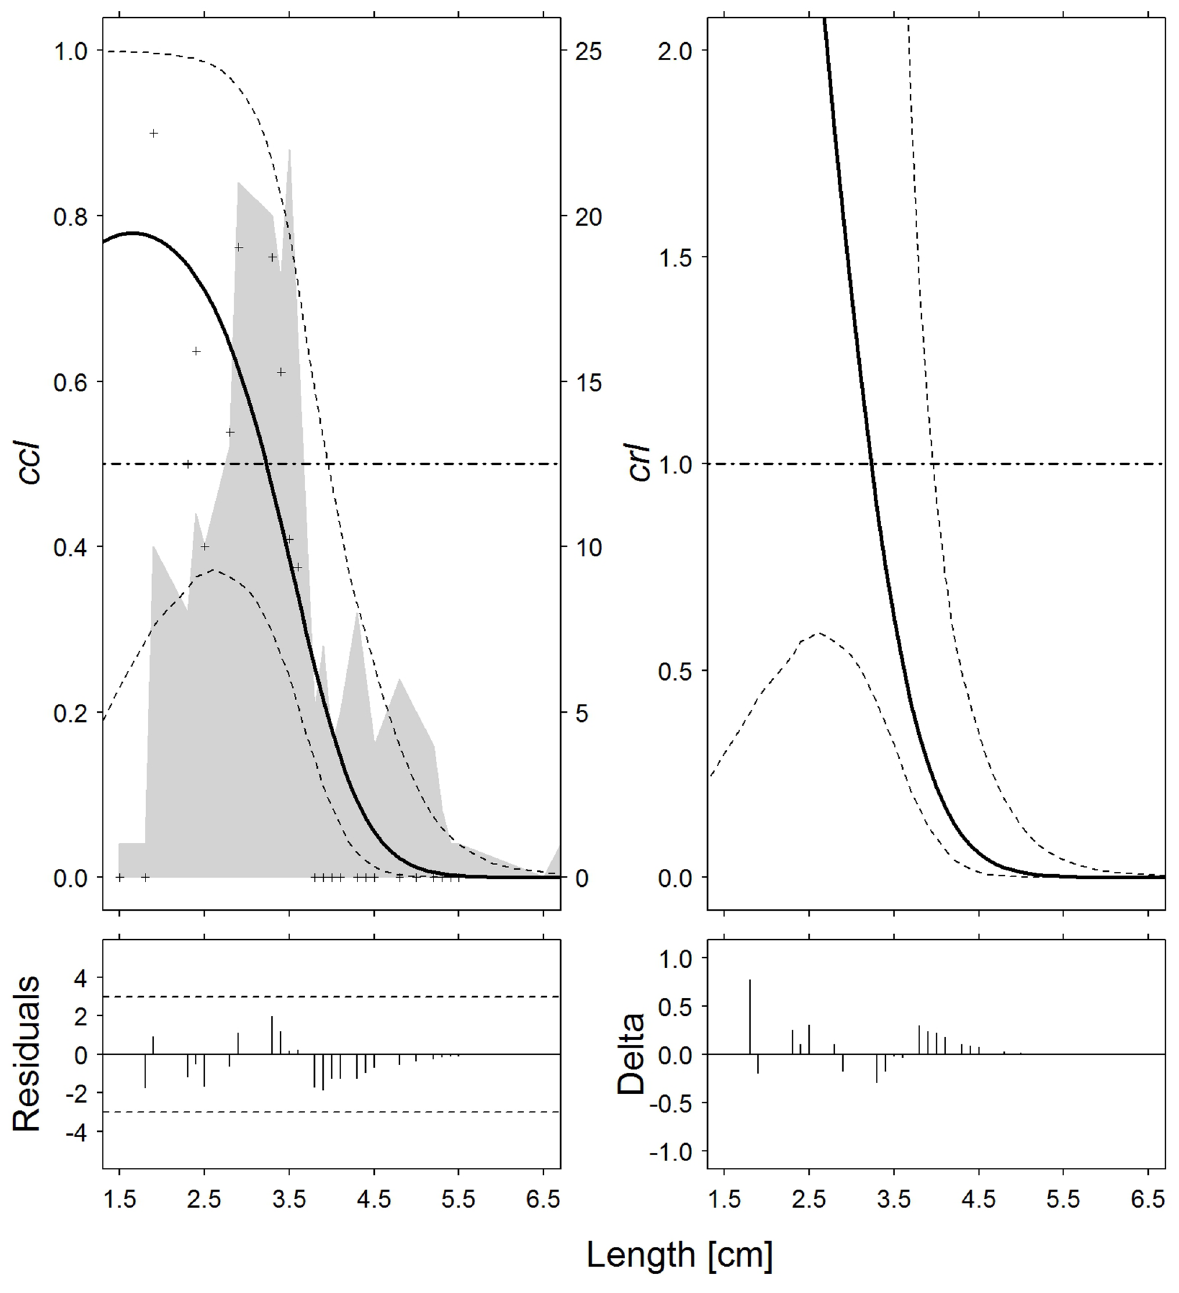
Fig 3. Norway lobster ( N . norvegicus ).Catch comparison rates ( cc 60-minute tows (solid curves). Crosses: experimental rates; thin dotted curves: 95% confidence intervals; grey solid curve: summed and raised catch populations for all hauls; horizontal dashed line: baseline of no effect on catch performance after changing tow duration. Partial residual plots ( bottom left )and delta dispersion ( bottom right ) for the two